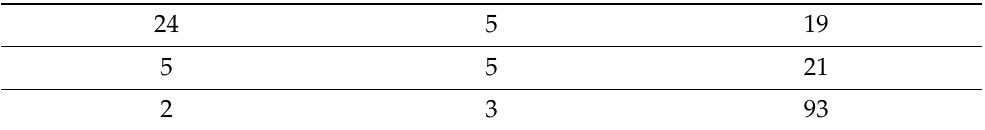
Table 15. Confusion matrix for Word2Vec embedding with the RFE (RF) feature selection method; 150